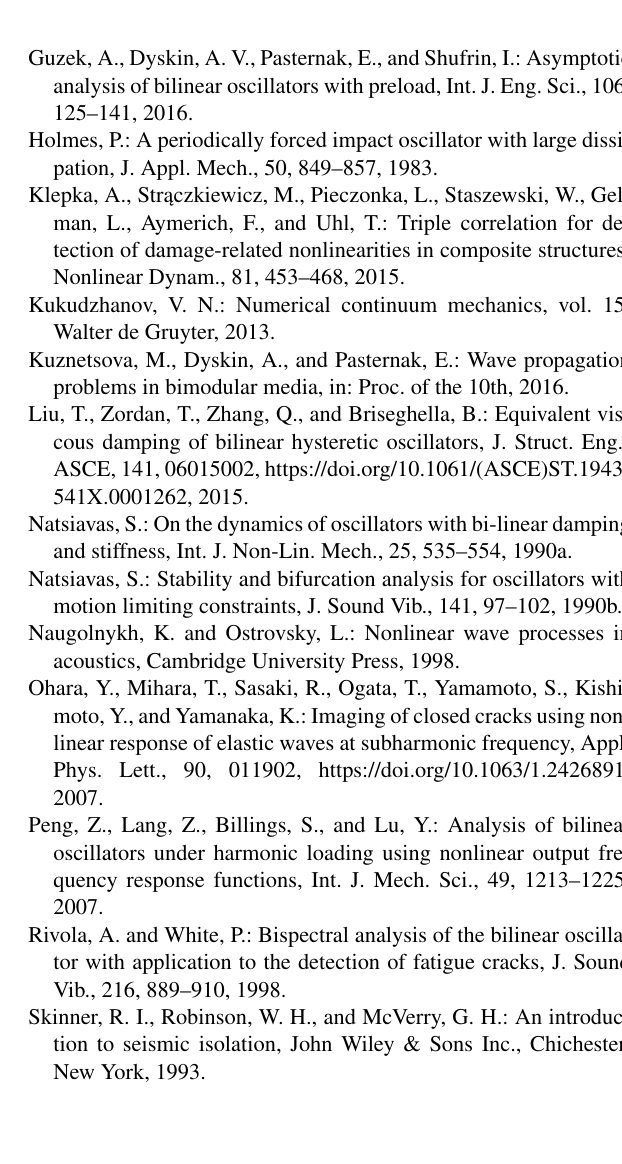
Data availability. No data sets were used in this